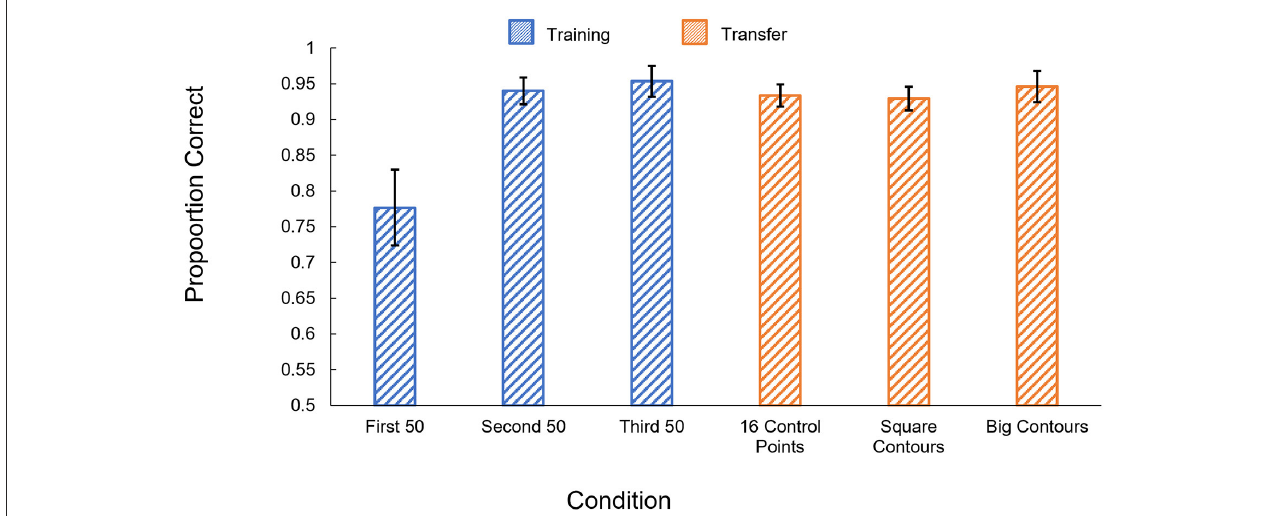
FIGURE6 Human results in Experiment 2c. Proportion correct is shown by condition. Blue: performance in the training phase, separated into 50-trial blocks. Orange: performance on the generalization tests. Error bars show ± one standard error of the mean.